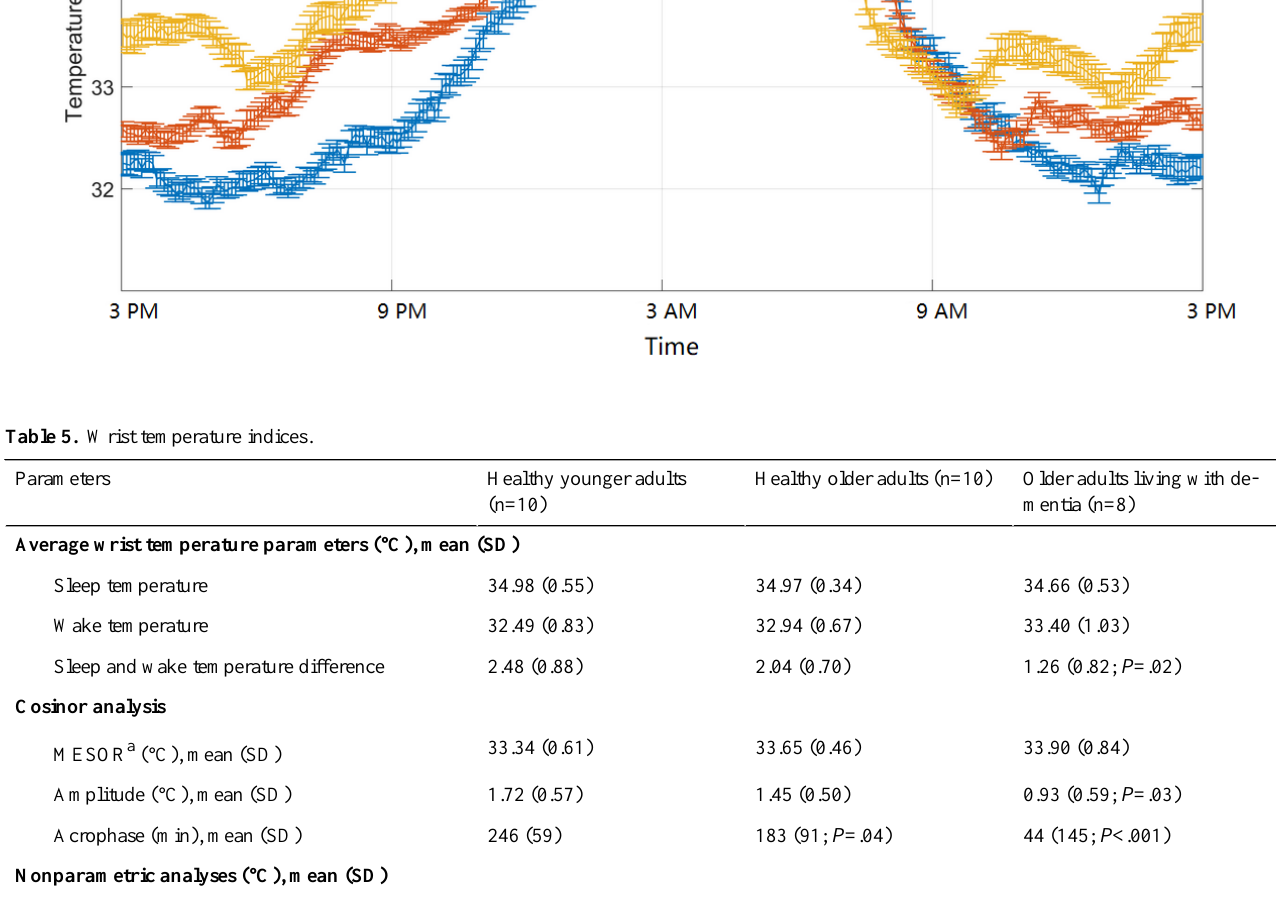
Case I: Healthy Younger Adult With Regular Sleep The healthy younger adult (YA1) was a 25-year-old man (PSQI=5 and ESS=3) who did not report any sleep disorders. One day of YA1 data, including wrist temperature, AX3 data, and sleep onset or offset detected by Mi Band 2, is shown in Figure 5. The sleep period and wake period can be distinguished using AX3 data, which shows that YA1 was mostly static with a relatively high and stable wrist temperature during sleep. The sleep onset and offset detected by the Mi Band 2 align well with changes in AX3 and wrist temperature